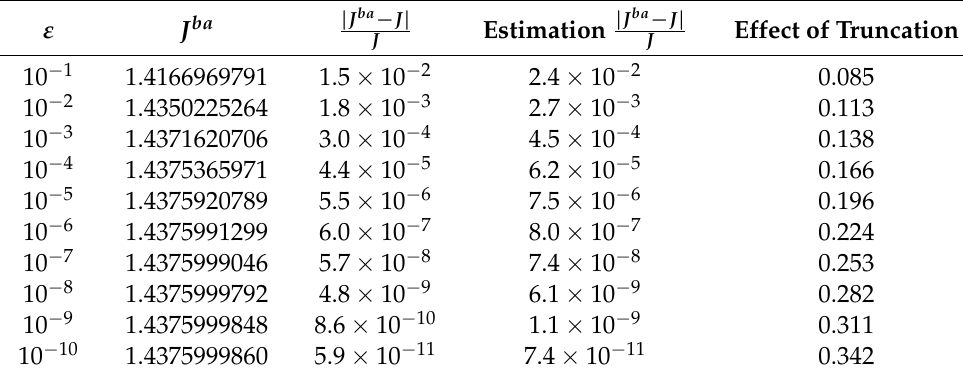
Table A2. Numerical analysis of estimation the performance measures of basic model with retrials based on the truncation of state